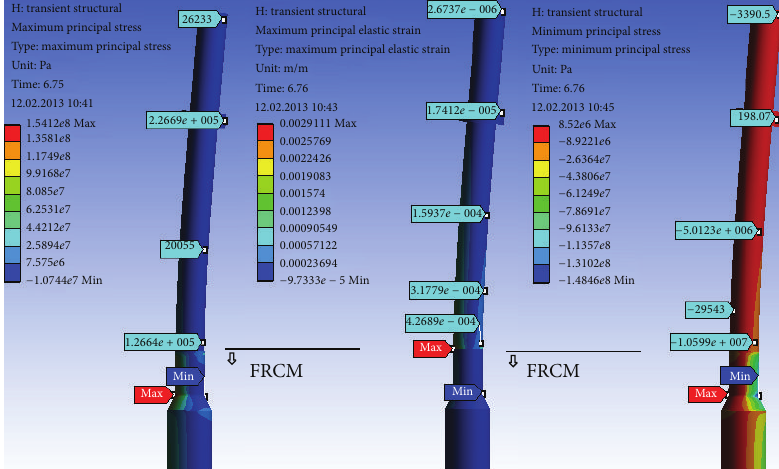
Figure 14: Maximum principal stress, maximum principal strain and minimum principal stress distribution for strengthened model under the effect of scaled synthetic accelerogram (in Pa).